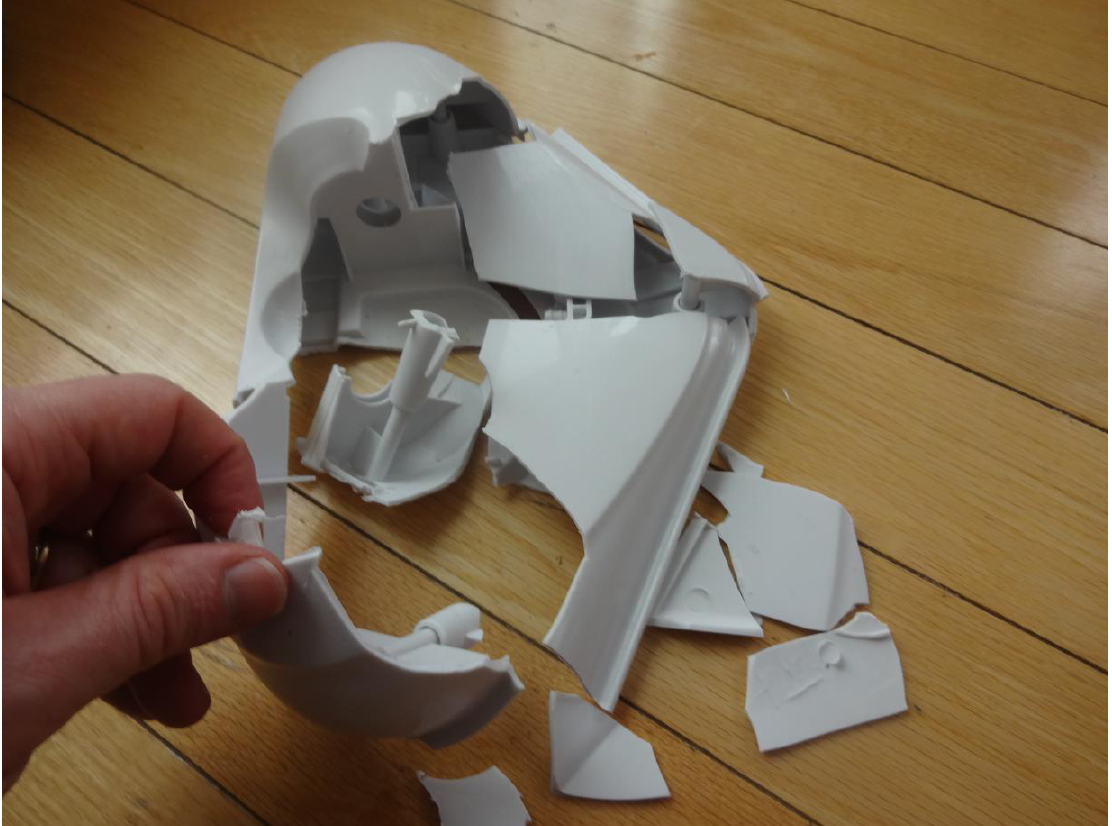
Figure 7. Broken commercial proprietary steamer head. The plastic became brittle and disintegrated under normal use.